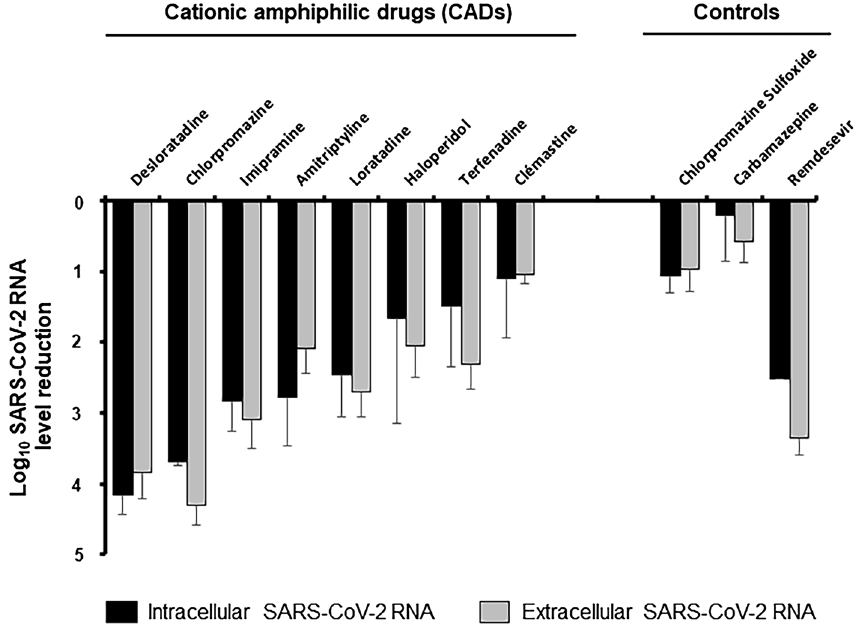
Figure 1. Antiviral effect of 10 µM of FDA-approved CADs on SARS-CoV-2 RNA production in Vero-E6 cells. Vero-E6 cells were treated with a fixed dose of 10 µM of the different CADs and infected with SARS-CoV-2 at an MOI of 0.2. Forty-eight hours post-infection, viral RNA was extracted from cells and cell supernatants and quantified by RT-qPCR. Intracellular (black bar) and extracellular (grey bar) SARS-CoV-2 RNA log decreases are shown related to untreated controls. Each bar represents the mean ± SD of at least two independent experiments performed in